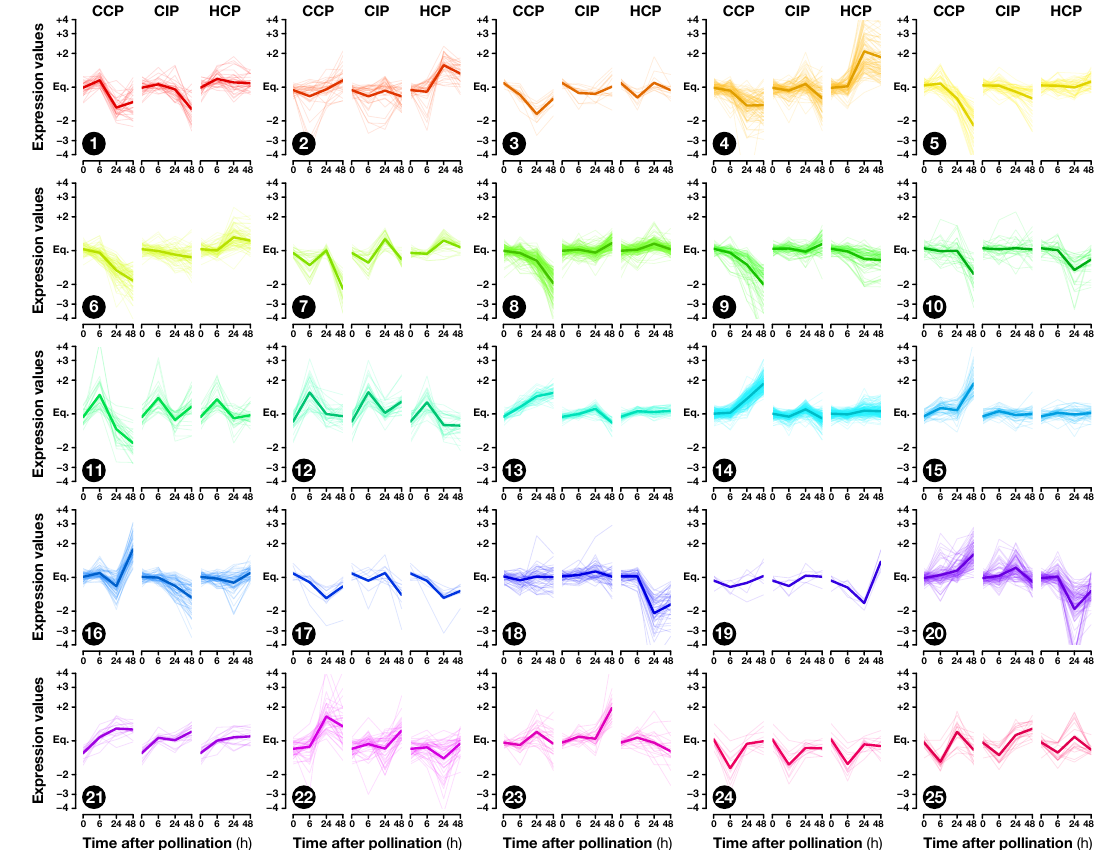
Figure 3. Transcription expression profiles in the 25 clusters obtained by k -means clustering.